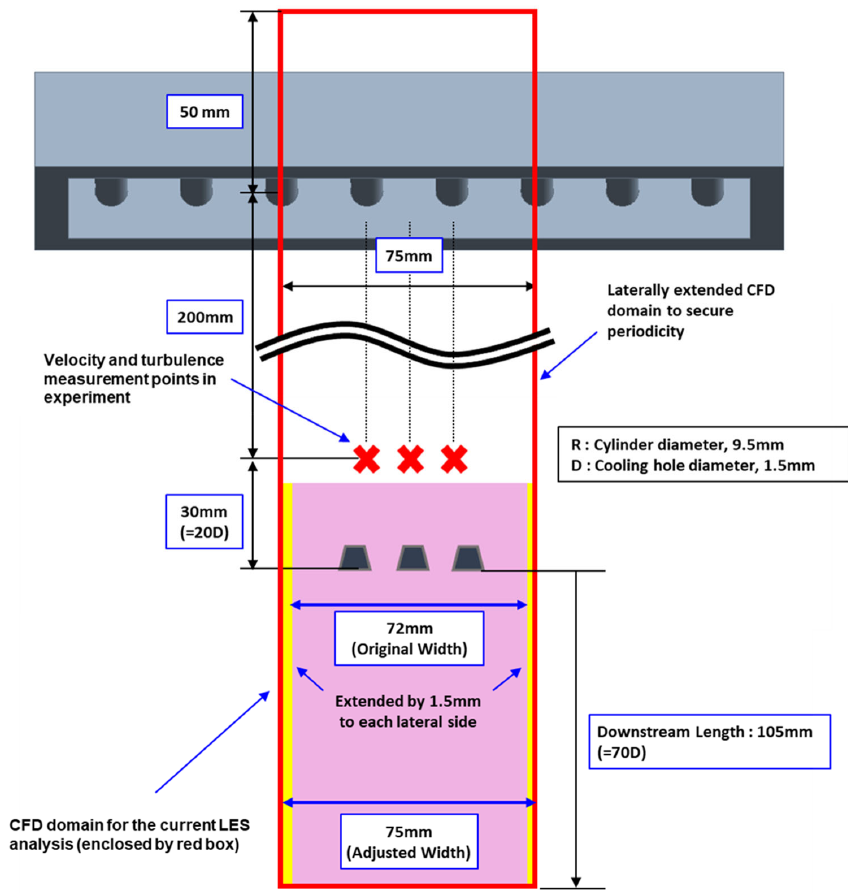
Figure 3. Top view of the CFD domain for the test section.